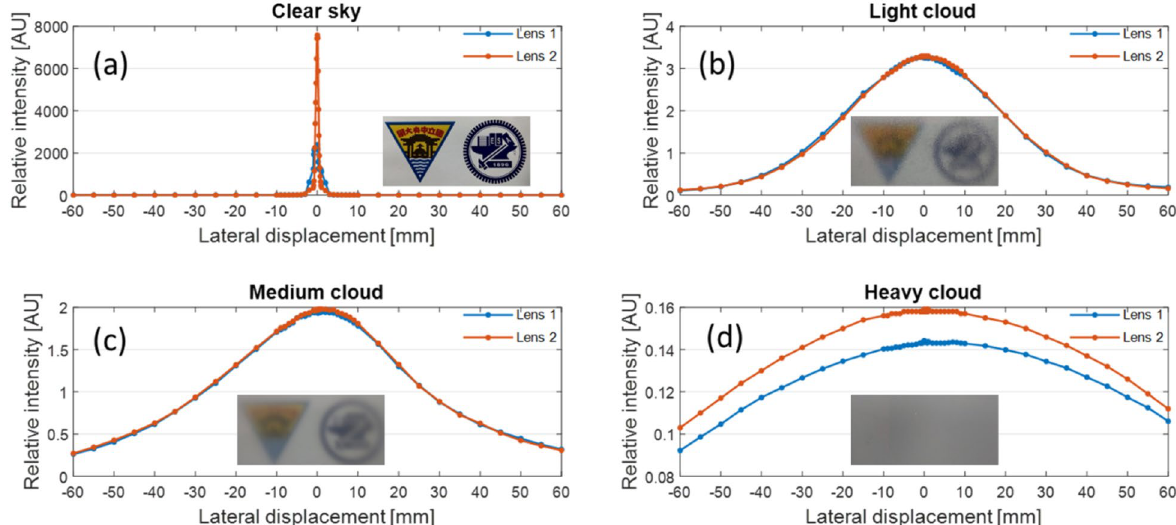
Figure 3. Lens focusing performance with the use of diffusive glasses to mimic weather at different conditions. The one-shot transmittances of the diffusers are ( a ) 100% without a diffuser for the clear sky, ( b ) 83% for the light cloud, ( c ) 65% for the medium cloud, and ( d ) 56% for the heavy